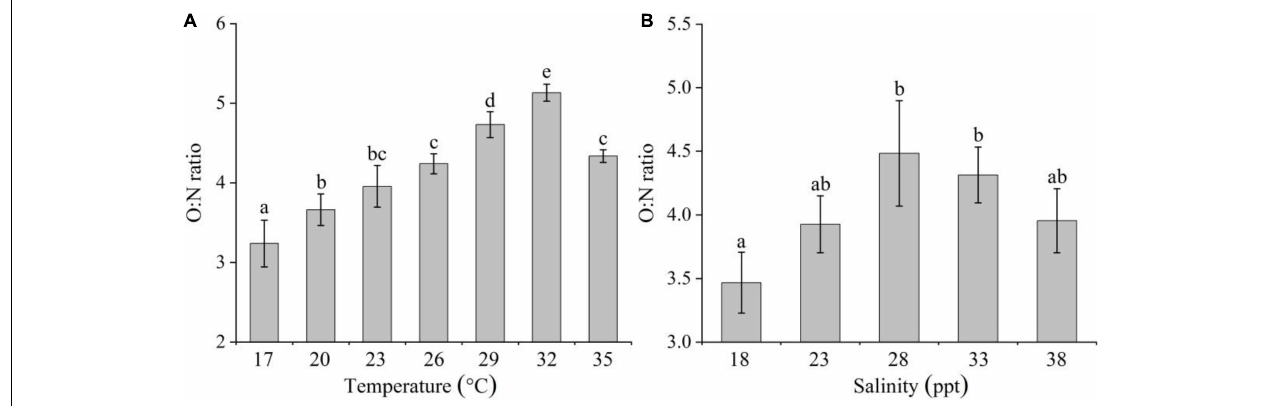
FIGURE 5 | Effects of temperature (A) and salinity (B) on the O:N ratio of Creseis acicula . Bars denote standard deviation. Different superscripts indicate significance ( P < 0.05) among the different temperature and salinity treatments, respectively.